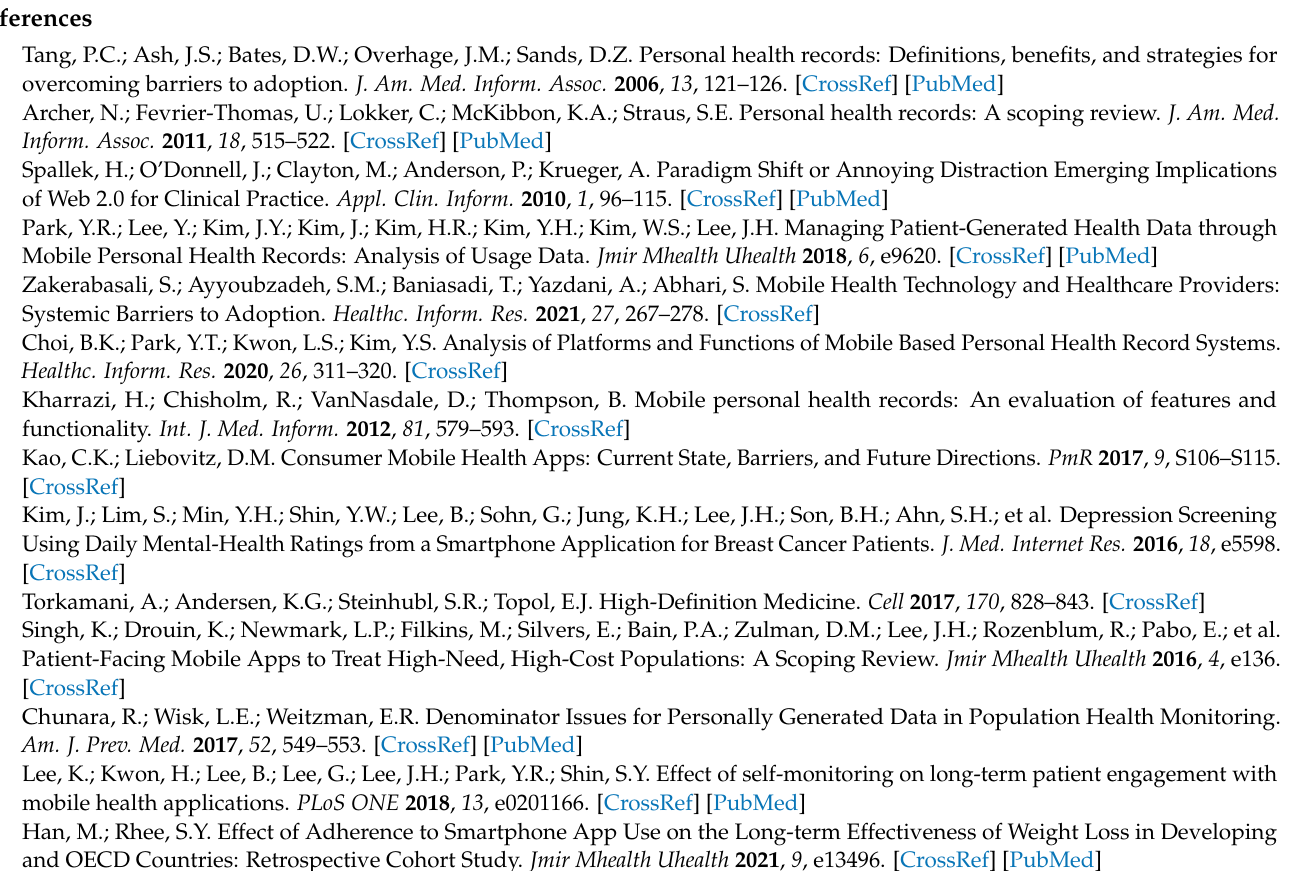
Figure A1. Age and number of first use of MCMH in children and adolescents.